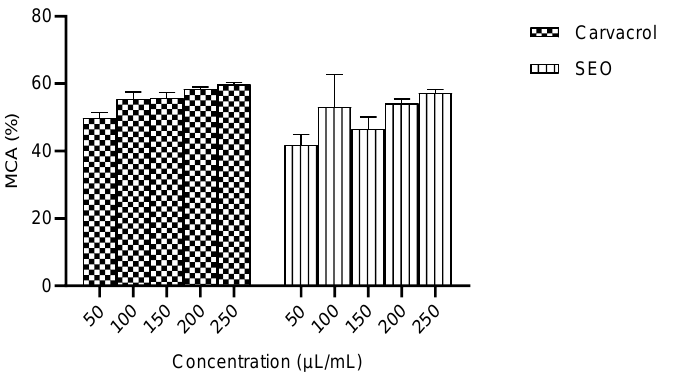
Figure 5. Percentage of ferrous metal chelating activity (IC 50 : carvacrol = 50.29 µL/mL. SEO = 71.06 µL/mL). MCA—metal chelating activity; SEO—seed essential oil.